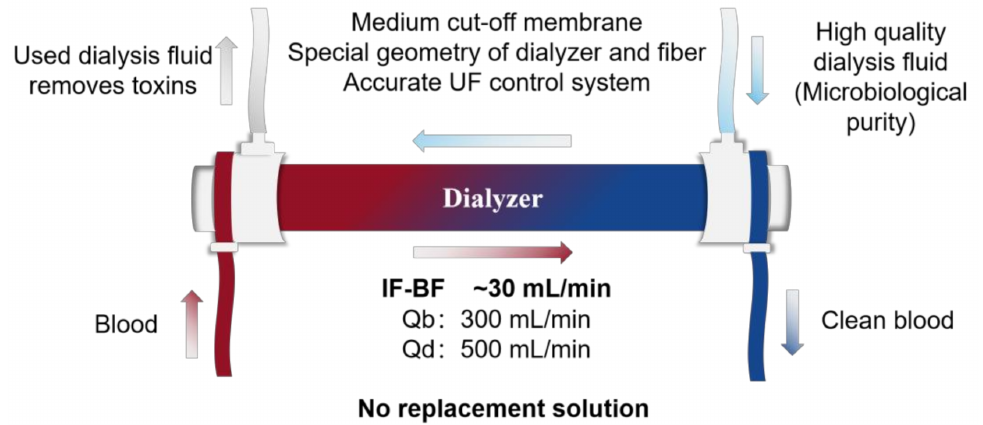
Figure 4. Requirements to perform expanded hemodialysis and related operational parameters (modified from Claudio Ronco)